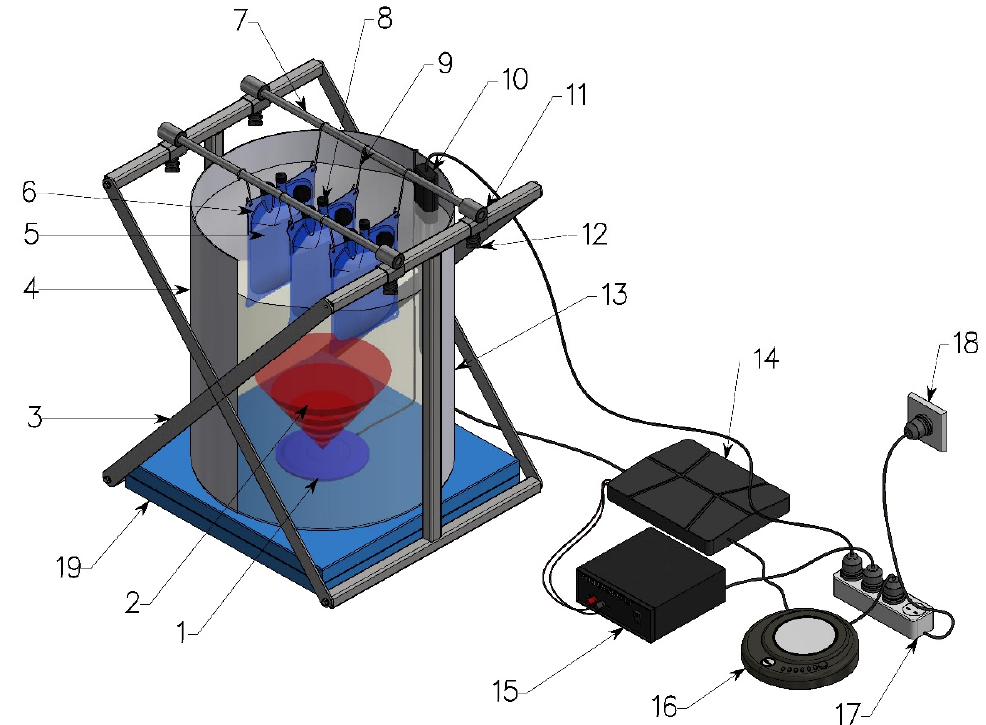
Figure 8. Experimental setup. 1. underwater speaker; 2. sound travelling via water; 3. support stand; 4. water level; 5. pitched wort; 6. submerged fabricated wine bag; 7. cross beam; 8. an airlock; 9. rubber band attached to hook for acoustically isolating suspended wine bag; 10. aquatic water heater; 11. foam tube; 12. adjustable knob; 13. plastic cylindrical container; 14. 1000 W power amplifier; 15. power adapter; 16. CD player; 17. multiple outlet extension cord; 18. wall socket; 19. foam pads for sound